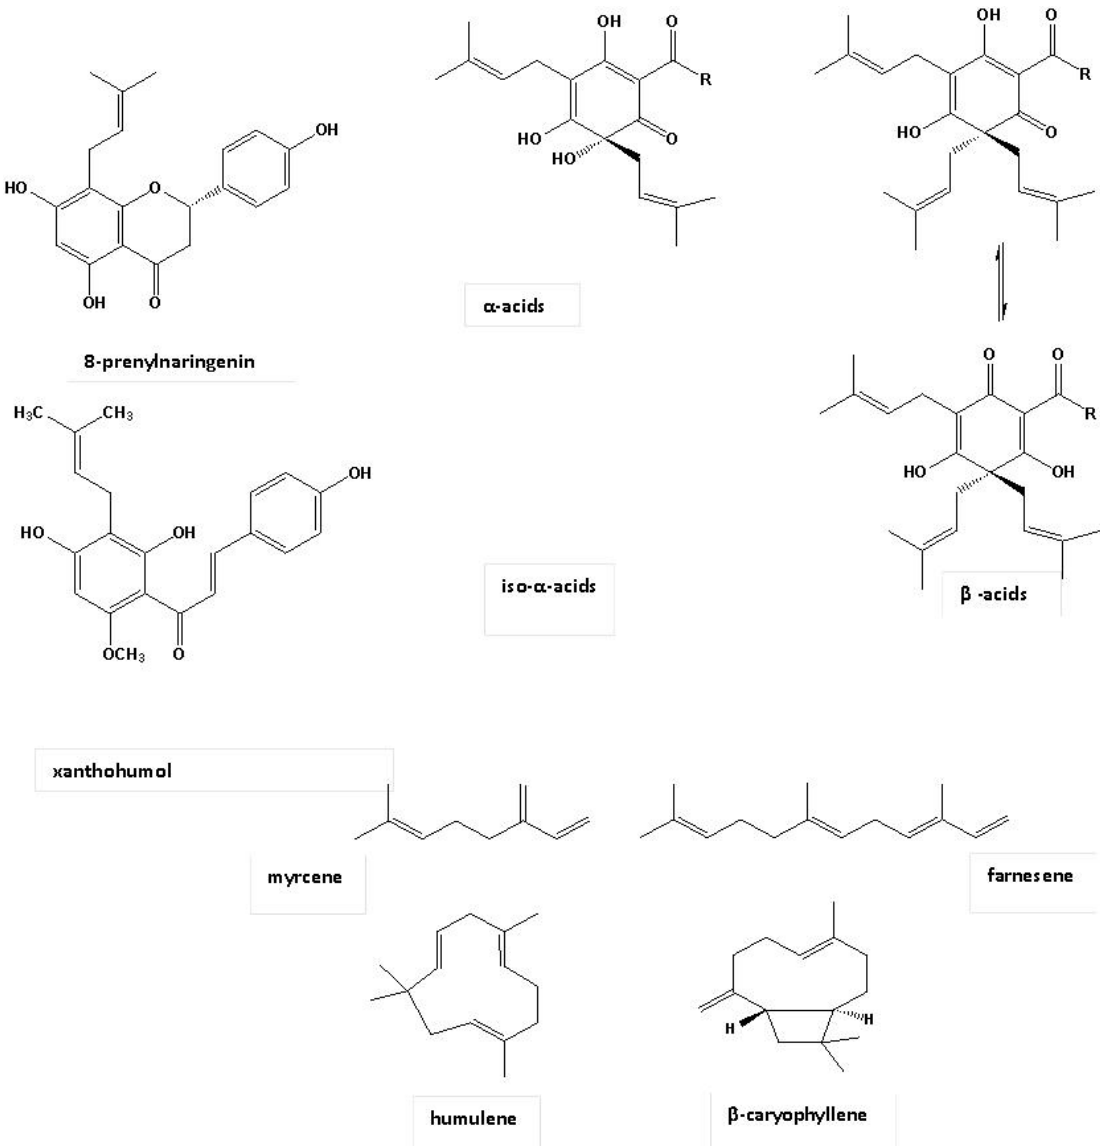
Figure 3: The main constituents of Humulus lupulus L., Cannabaceae